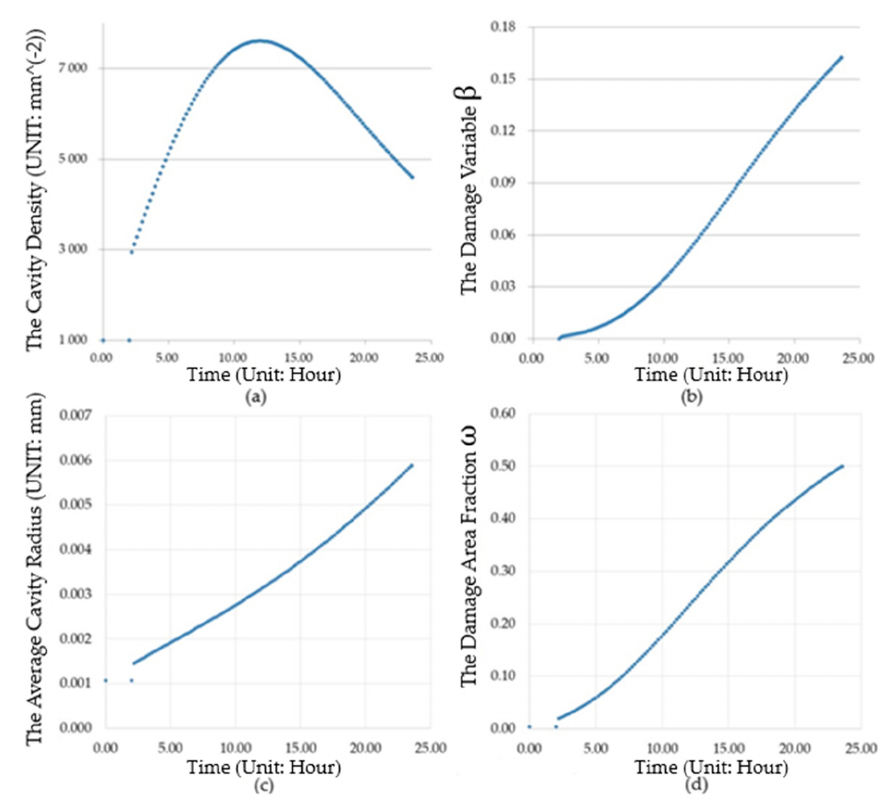
Figure 10. Evolution of the Position A. ( a ) The evolution of the cavity density versus the time. ( b ) The evolution of the average radius a versus the time. ( c ) The evolution of the average cavity radius a versus the time. ( d ) The damage area fraction versus the time.